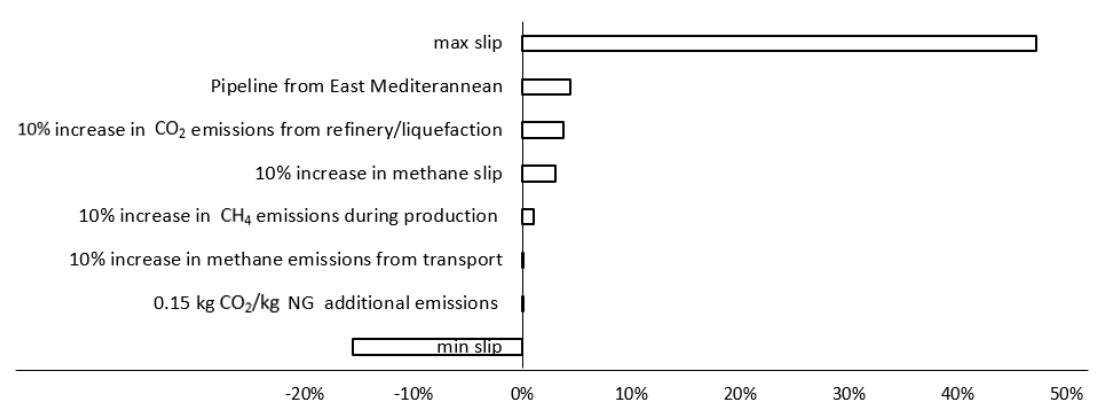
Figure 10. Change (%) of Life Cycle GHG emissions due to the scenario analysis (ceteris paribus).